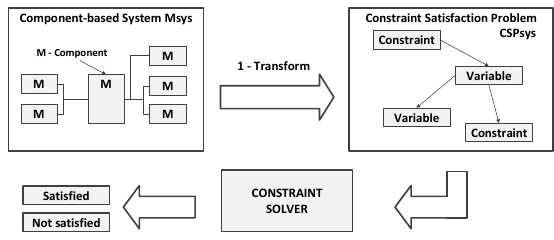
Fig. 3. Overview of the proposed verification method: (1) transformation of the component-based system M sys into the CSP representation CSP sys , (2) verification of the com- position CSP sys by solving a